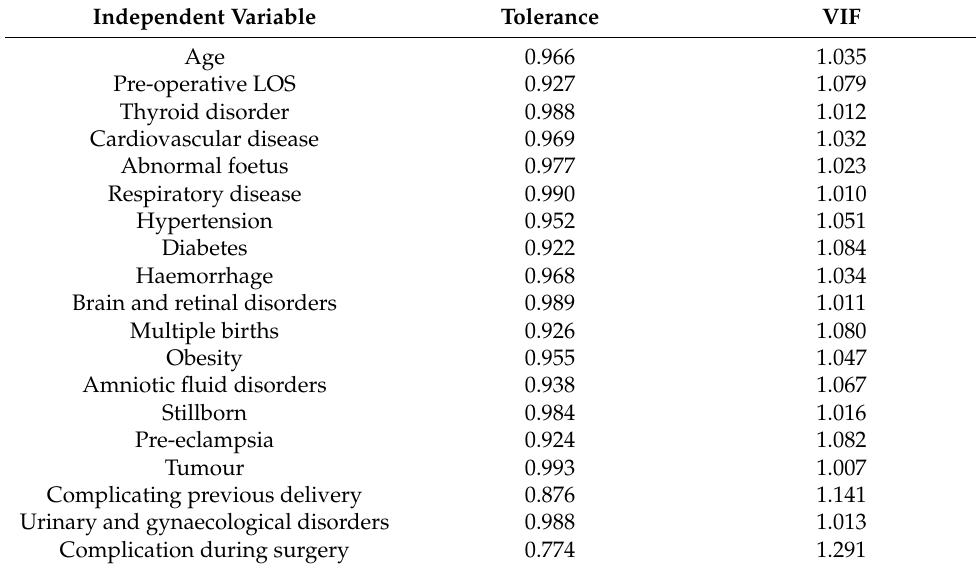
Table 2. Tolerance and Variance Inflation Factor for the multiple linear regression model.